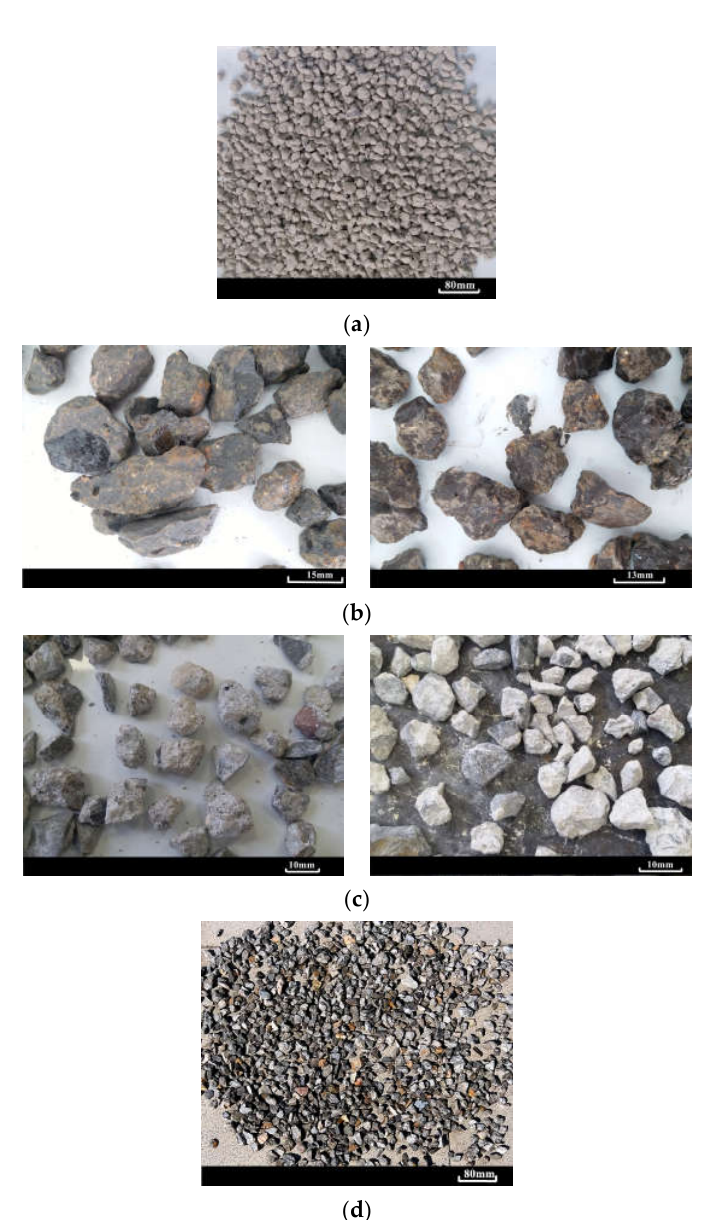
Figure 2. The appearance of the aggregate wrapped with different material slurry: ( a ) Wrapped with cement slurry; ( b ) Wrapped with silica fume slurry (left: 150 nm, right: 300 nm); ( c ) Wrapped with silicon nitride slurry (left: 20 nm, right: 500 nm); ( d ) Wrapped with silicone hydrophobic agent.